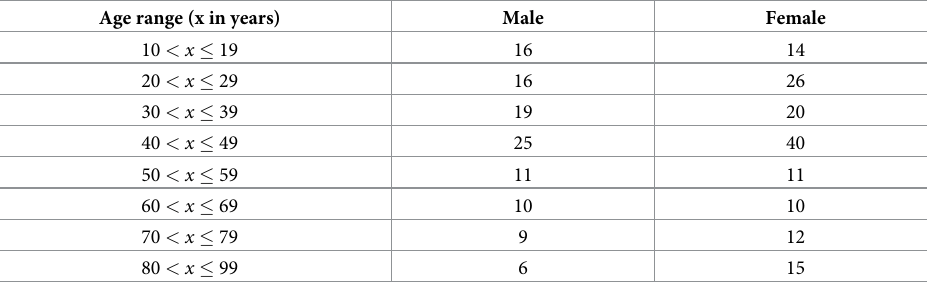
Table 6. Age and gender distribution of the individuals from